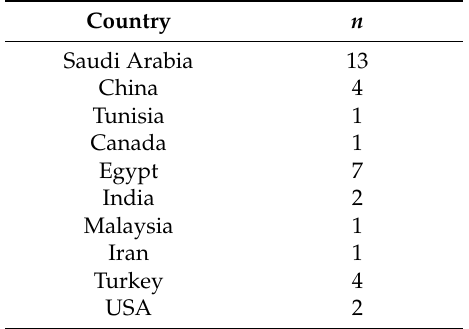
Figure 1. Assessment of eligible articles according to PRISMA 2009 Flow Diagram [48]. Table 2. Publication country of first authors and respective number of